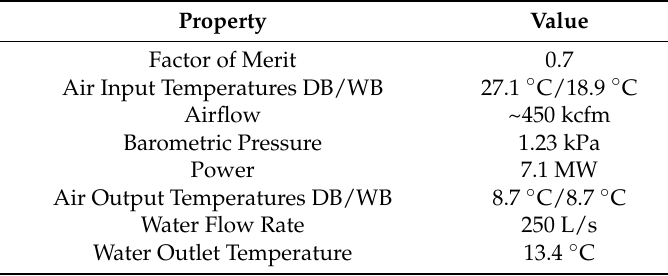
Table 6. Cooling characteristics of the underground plant.